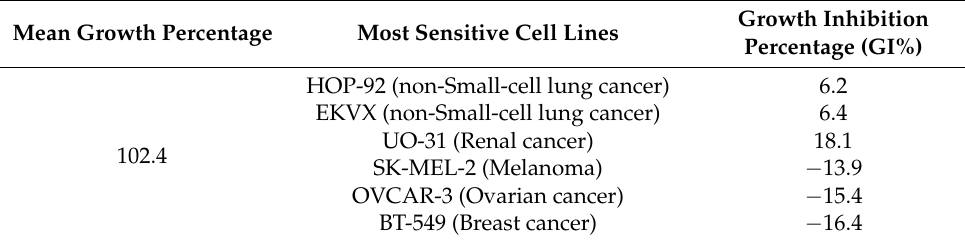
Table 8. Remarkable anticancer results for compound 3